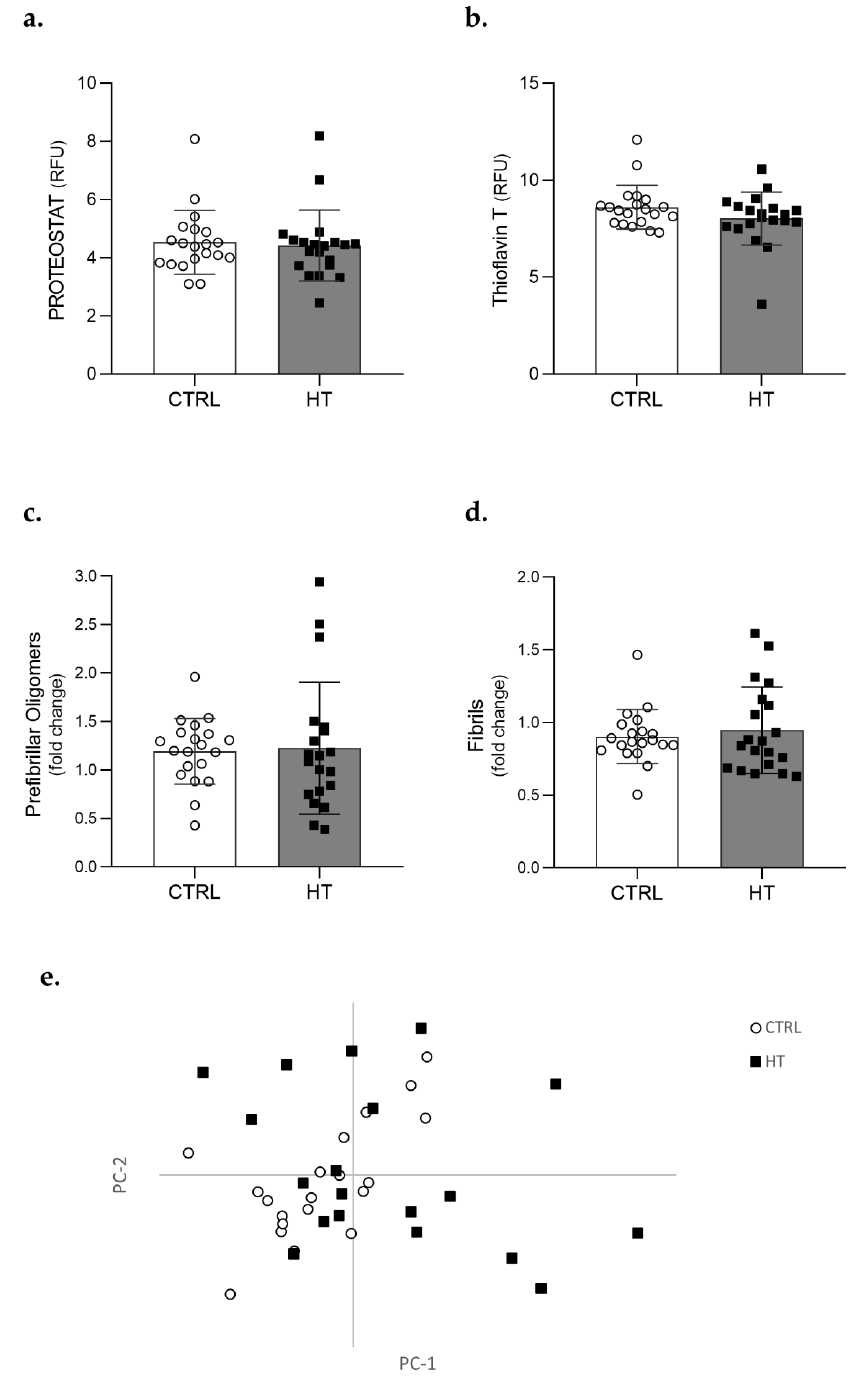
Figure 1. Protein aggregation profile in plasma samples of control and individuals with hypertension. Plasma protein aggregation was assessed by fluorometric assays with Proteostat ( a ) and Thioflavin T ( b ), immunoassays targeting conformationally distinct aggregates such as prefibrillar oligomers ( c ) and fibrils ( d ), and through FTIR ( e ). Two-tailed unpaired t-tests or Mann–Whitney tests were applied to compare controls (CTRL, ) and individuals with hypertension (HT, (cid:4) ) in fluorometric and (cid:35) immunoassays. All samples were normalized to the reference sample and levels are represented as fold changes relative to this reference sample. Bars represent mean ± S.E.M. FTIR data were obtained by Principal Component Analysis (PCA) applied to the normalized second-derivative